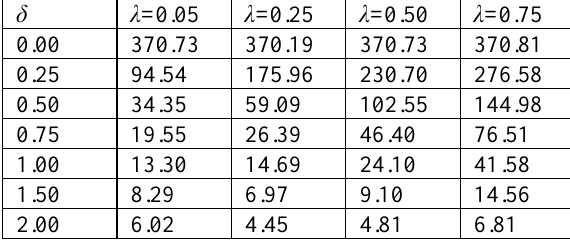
Table 5. SDRLs for the EWMA median chart based on RSS scheme when